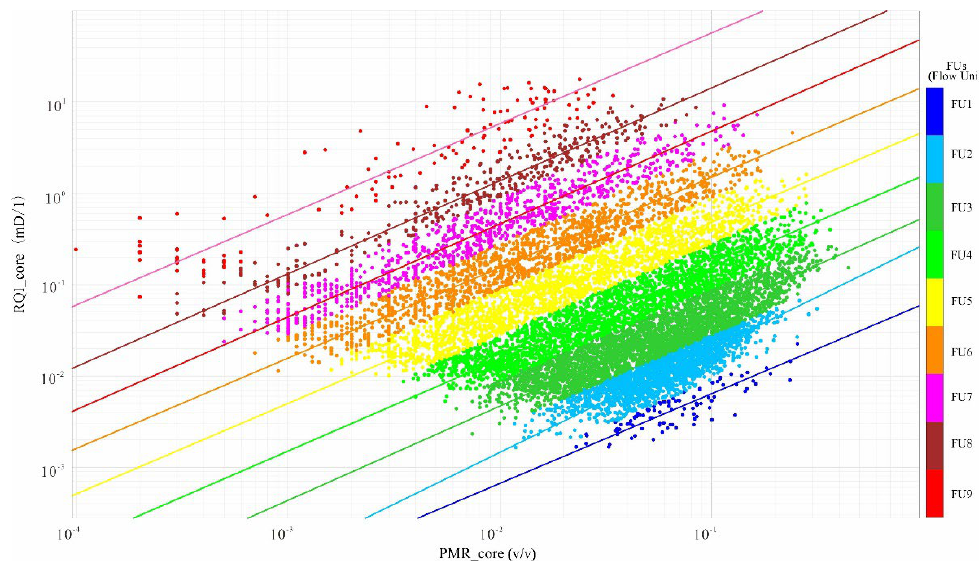
Figure 6. RQI − PMR cross plots of different flow units. Table 2. Statistics of Parameters of Different Flow Units of the Callovian-Oxfordian stage.